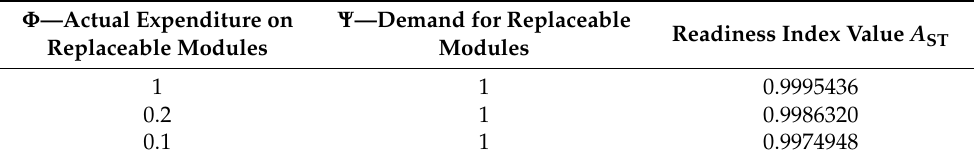
Table 3. List of impact values of a toll collection station replaceable module demand index and the index on expenditure on replaceable modules on the value of its readiness index. Source: own study based on